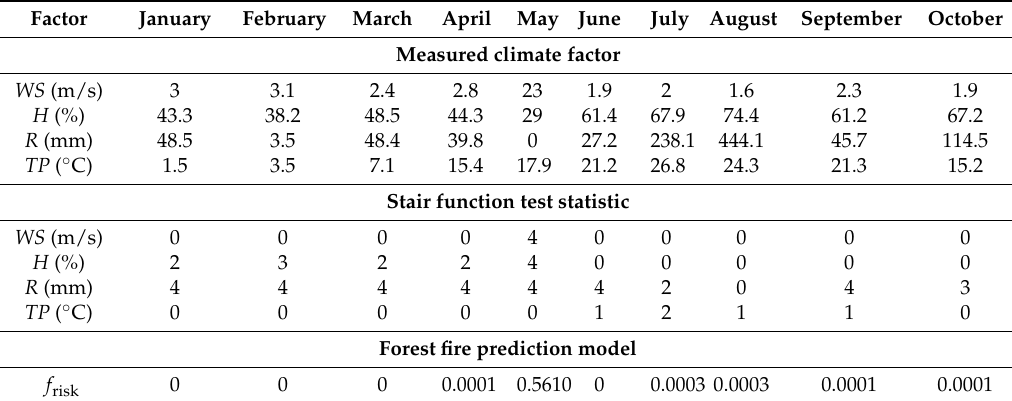
Table 3. Forest fire risk analysis for Mt. Gangneung, 2017.